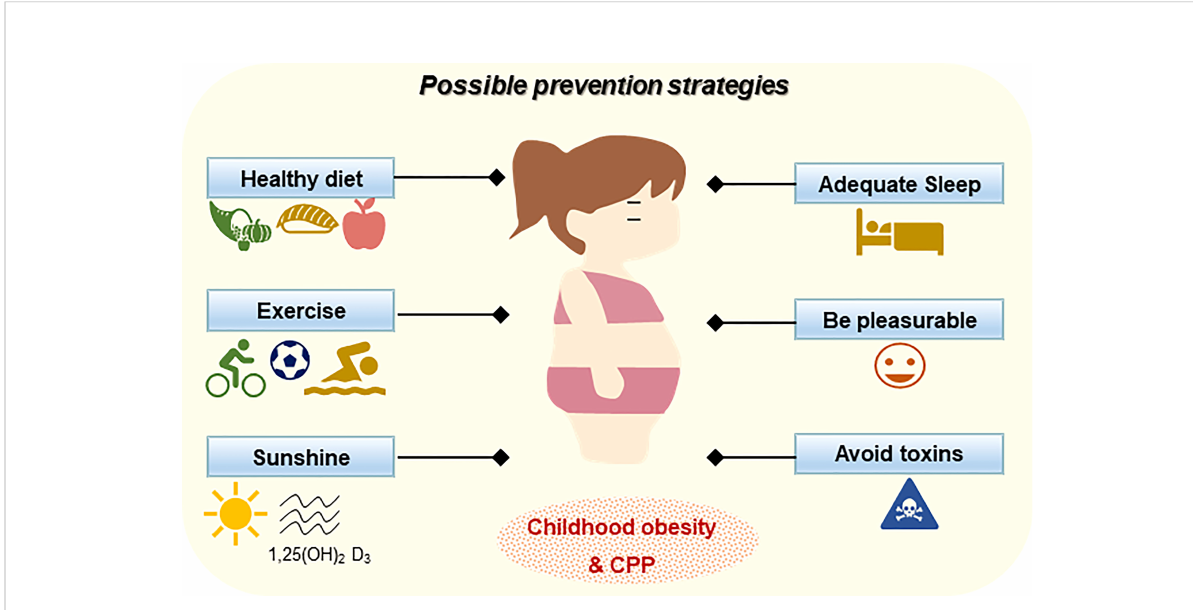
FIGURE 2 The possible prevention strategies for childhood obesity and